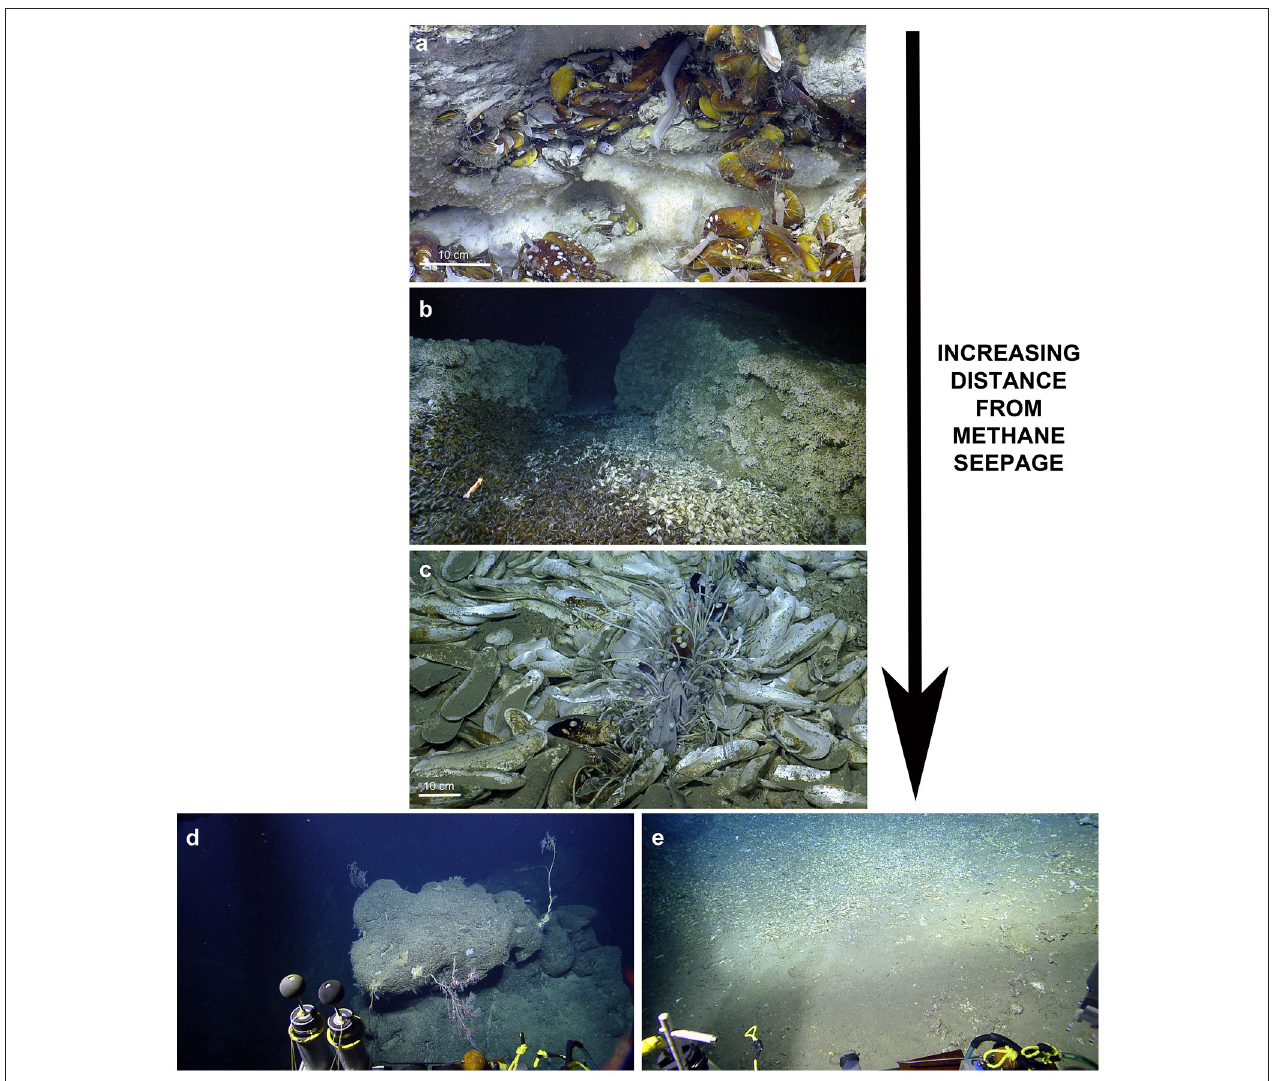
FIGURE 3 | Zonation at El Pilar off Trinidad and Tobago. The five habitats observed at the four El Pilar sites, in order of increasing distance from methane seepage: (a) Dense aggregations of amphipods on methane hydrate, which is surrounded by chemosynthetic Bathymodiolus childressi , Alvinocaris cf. muricola , Pachycara caribbaeum, and other fauna. (b) Abundant filter-feeders (e.g., Neovermilia serpulids, Stenohelia profunda , Haplosclerida n. sp.) on authigenic carbonate structures adjacent to Bathymodiolus mussel beds. (c) Bathymodiolus shell aggregations, which can sometimes have discrete bushes of Lamellibrachia sp. 2, live B. boomerang , A. cf. muricola , Kanoia cf. meroglypta gastropods, and other small fauna. Furthest from the active methane seeps are (d) authigenic carbonates that host large sparse octocorals and their commensals and/or (e) inactive sedimented